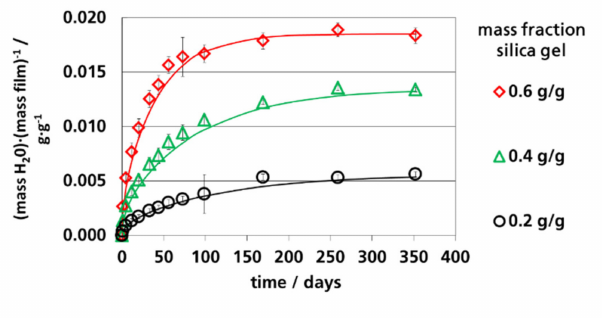
Figure 6. Water vapor absorption of films with dispersed silica gel at 9% RH and 23 ◦ C, lines: Calculated using Equation (2) ( n = 100).